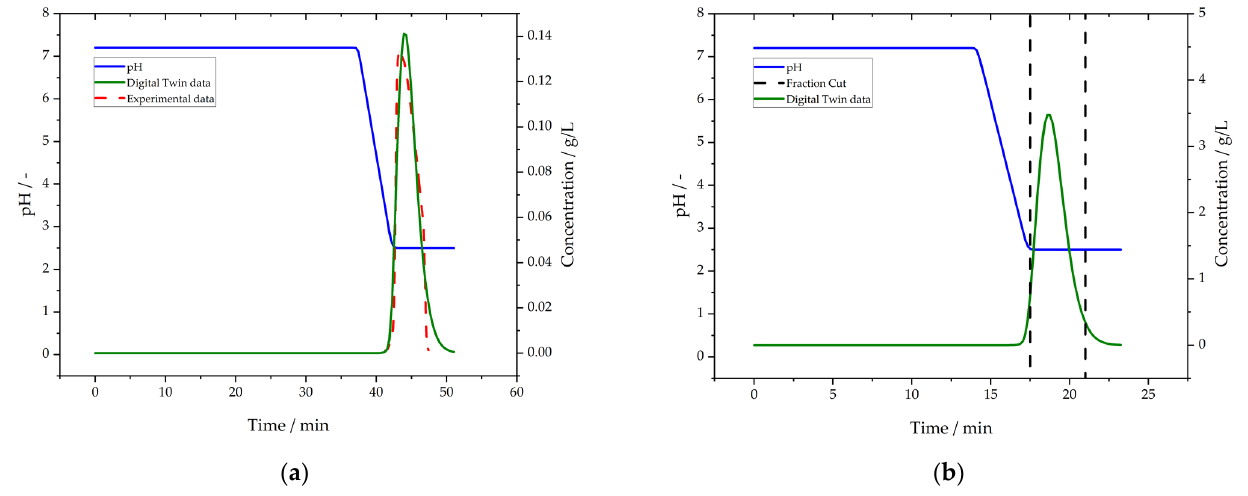
Figure 9. Chromatograms for the laboratory process ( a ) and the scaled-up process ( b ). The dashed red line gives the experimental data, black shows a theoretical fraction cut, the solid green lines give the data derived from the Digital Twin and the solid blue lines give the gradients.